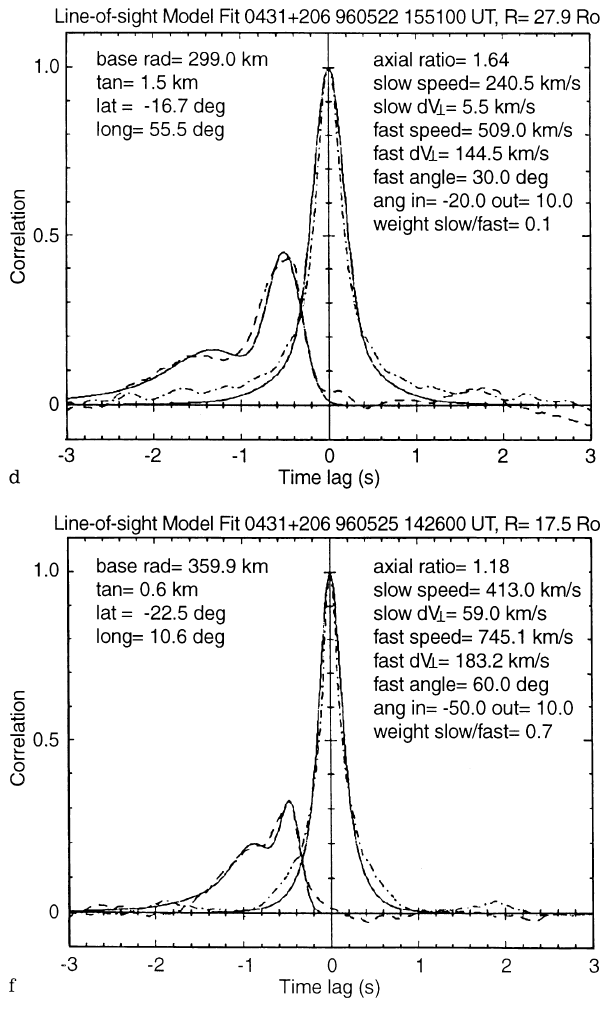
Fig. 11. a White-light map of the coronaat 1.7 R , centred on 22 May 1996. The IPS ray-path for the observation of 0431+206 at 27.9 R is shown projected down to 1.7 R with an assumed velocity of 750 km s ) 1 . In this figure (and all subsequent white-light maps) the line corresponding to a projection velocity of 325 km s ) 1 is omitted for clarity. b White-light map of the corona at 1.7 R , centred on 23 May 1996. The IPS ray-path for the observation of 0431+206 at 24.6 R is shown projected down to 1.7 R with an assumed velocity of 750 km s ) 1 . c White-light map of the corona at 1.7 R , centred on 25 May 1996. The IPS ray-path for the observation of 0431+206 at 17.9 R is shown projected down to 1.7 R with assumed velocities of 750 km s ) 1 . d Correlation functions from the observation of 0431+206 on 22 May 1996. The observed correlation functions (in parts d, e and f) are shown as broken lines and the results of the model